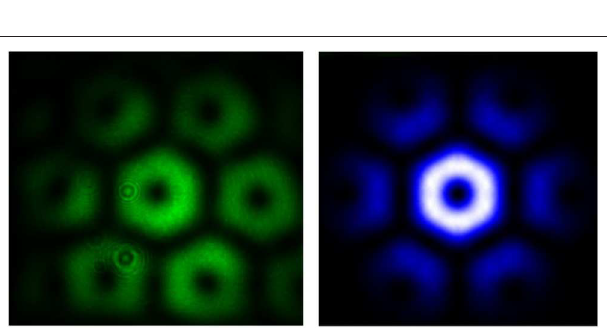
FIGURE 8 | Experimental intensity distribution of the vortex beam l result of numerical simulation [21]